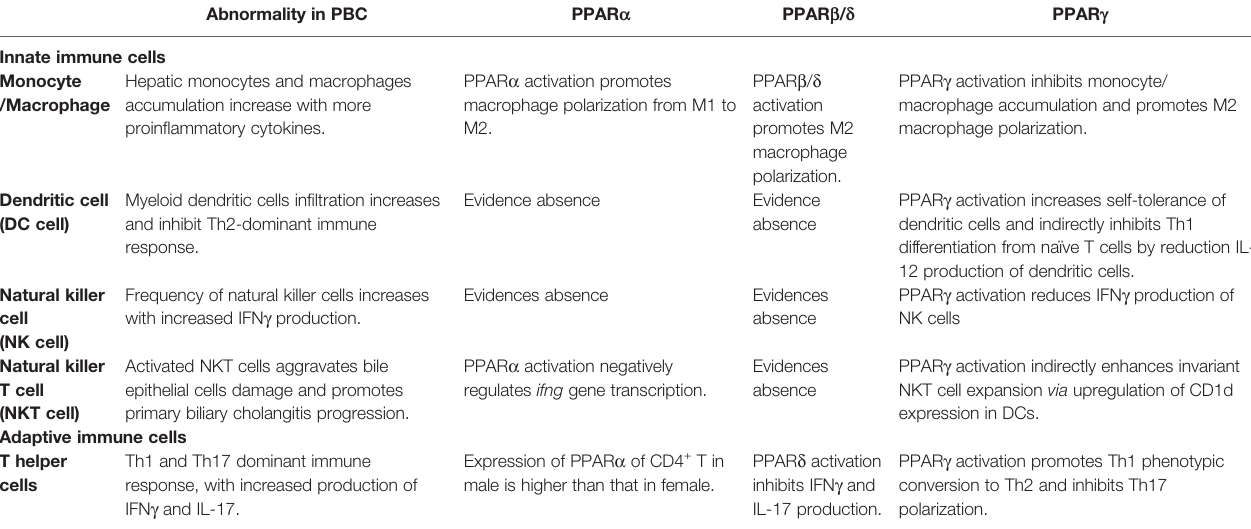
TABLE 2 | Regulatory effects of different PPAR subtypes on diverse immune